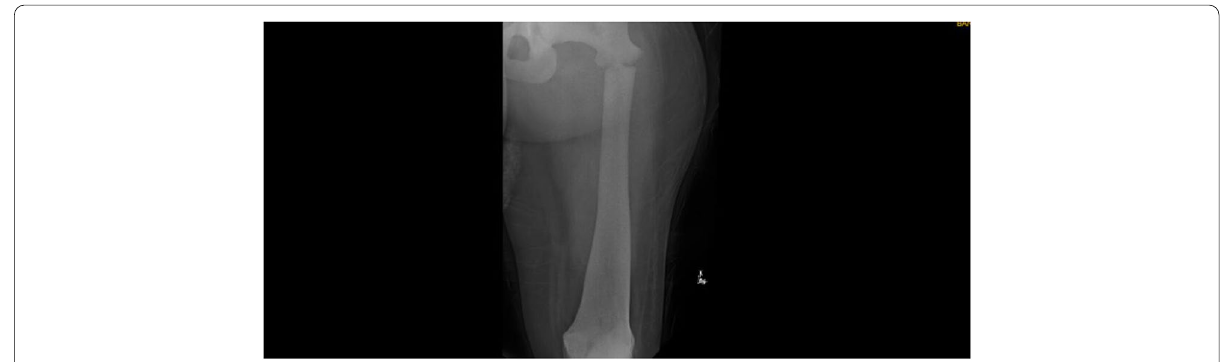
Fig. 4 Erlenmeyer flask deformity of left femur with subtrochanteric fracture